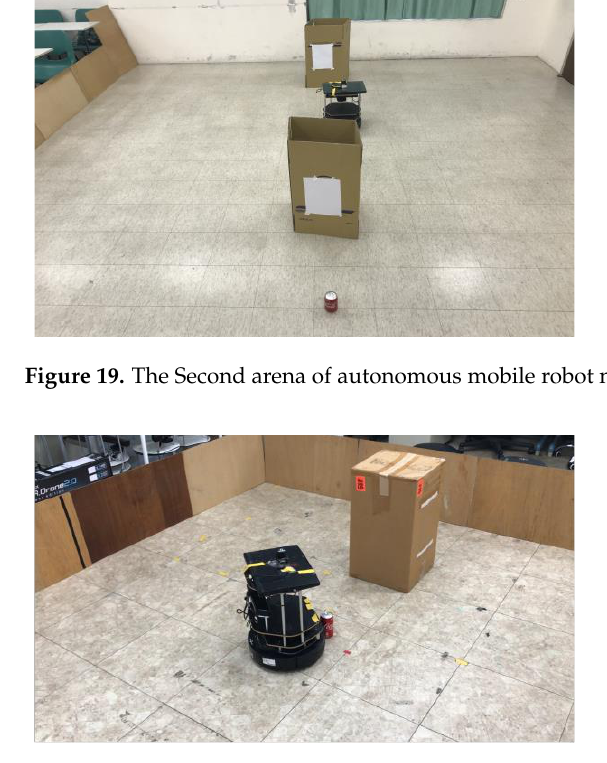
Figure 21. Third-person view of mobile robot reaching the target object in the second arena. 5. Discussion In the average cumulative reward per episode of a DQN and DDQN agent as shown in Figures 12 and 15, respectively, it can be noticed that in the first episodes the average cumulative reward of the DDQN agent is negative but not for the DQN agent. A DDQN agent takes a longer time and more episodes to achieve a high cumulative reward, while a DQN agent takes less time and fewer episodes to even achieve a high cumulative re- ward. However, the DDQN agent’s cumulative reward is more consistent than the DQN agent’s. The average cumulative TD error of the DQN and DDQN agents as shown in Figures 13 and 16, respectively, are decrementing with episodes, which indicates that the error difference between the target critic and the critic networks of DQN and DDQN agents are reducing. The average cumulative reward received by the DQN and DDQN agents in the Gazebo simulator after training 150,000 time steps for different discount fac- tor values is shown in Figures 14 and 17. Thus, from Figures 14 and 17, it can be observed that a 0.99 discount factor value is the best for obtaining the highest average cumulative